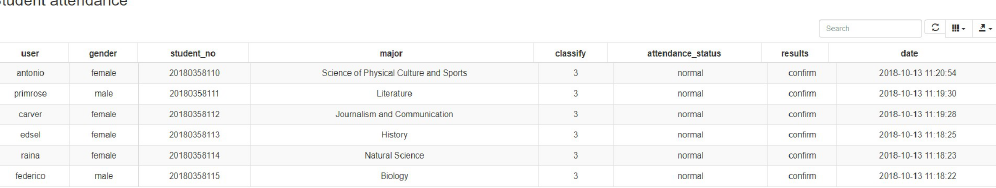
Figure 5. Analysis of student attendance